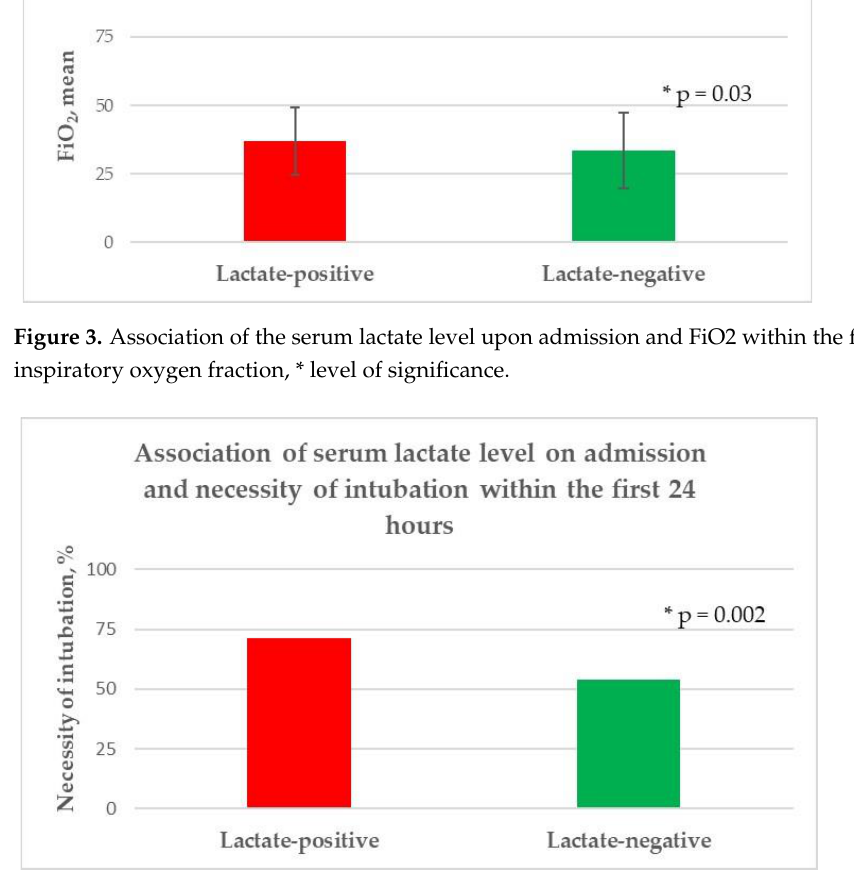
Figure 4. Association of the serum lactate level upon admission and necessity of endotracheal intubation within the first 24 h , * level of significance.